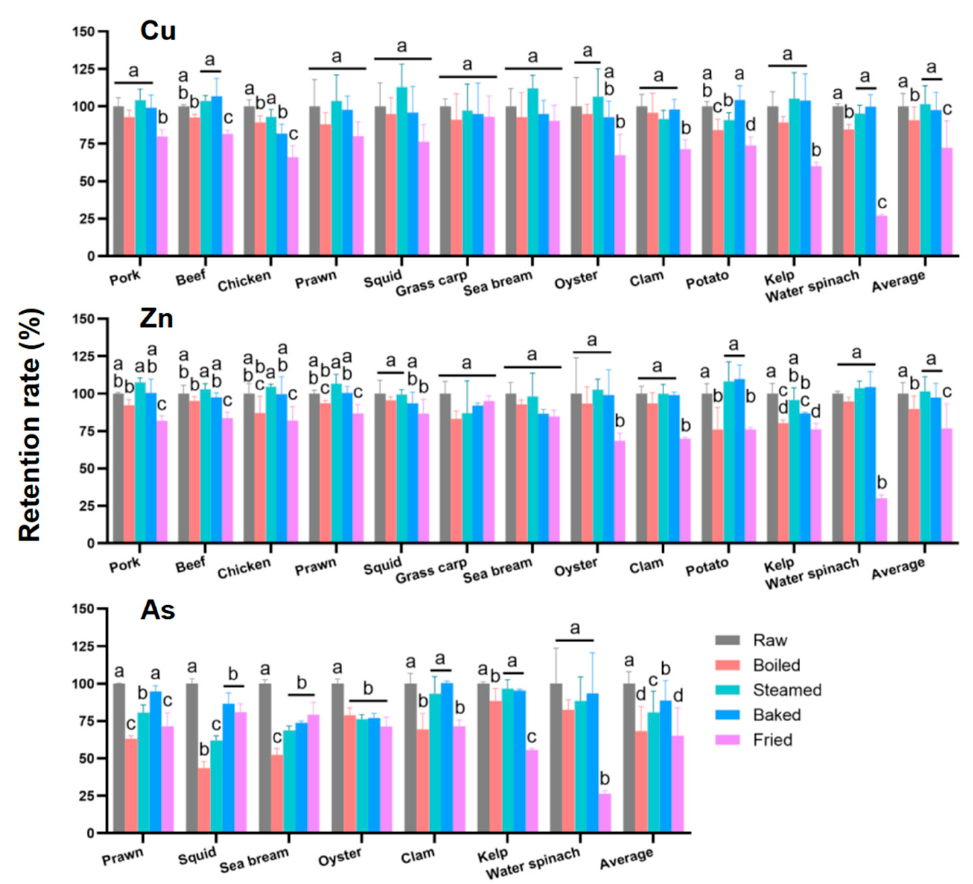
Figure 3. The retention rate of Cu, Zn, and As in food ingredients. Data are expressed as means ± SD ( n = 3). Different letters (a, b, c, d) represent significant differences among treatments ( p < 0.05).